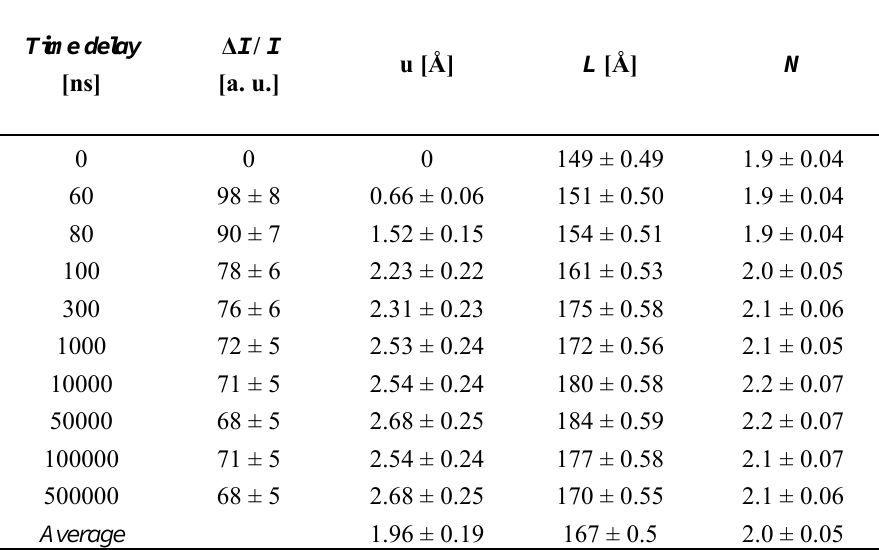
Table 1. Results for Patterson and Scherrer analysis. In the first column the relative decrease of intensity at different times after optical excitation is depicted. The second column shows the change on the lattice periodic distance u . The third column presents the thickness of the crystallite at different times, and the 4 th column shows the number of lamellar planes which form the